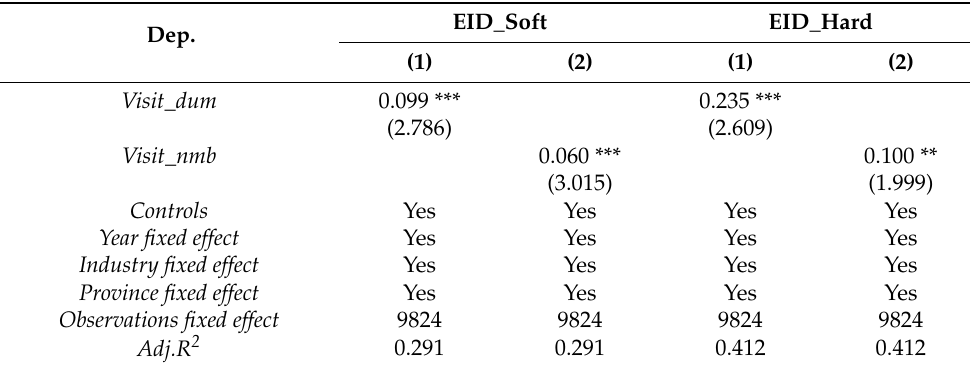
Table 6. The regression results of replacing the dependent variables.